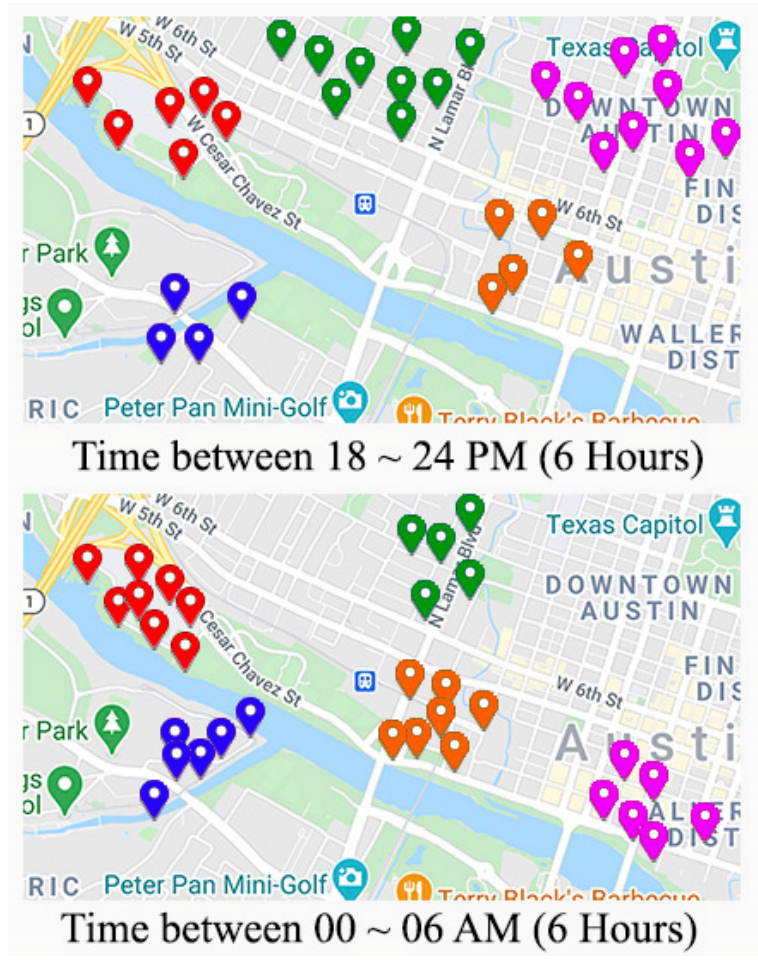
Figure 1. An illustration of applying clustering approach to two different time span of one user.